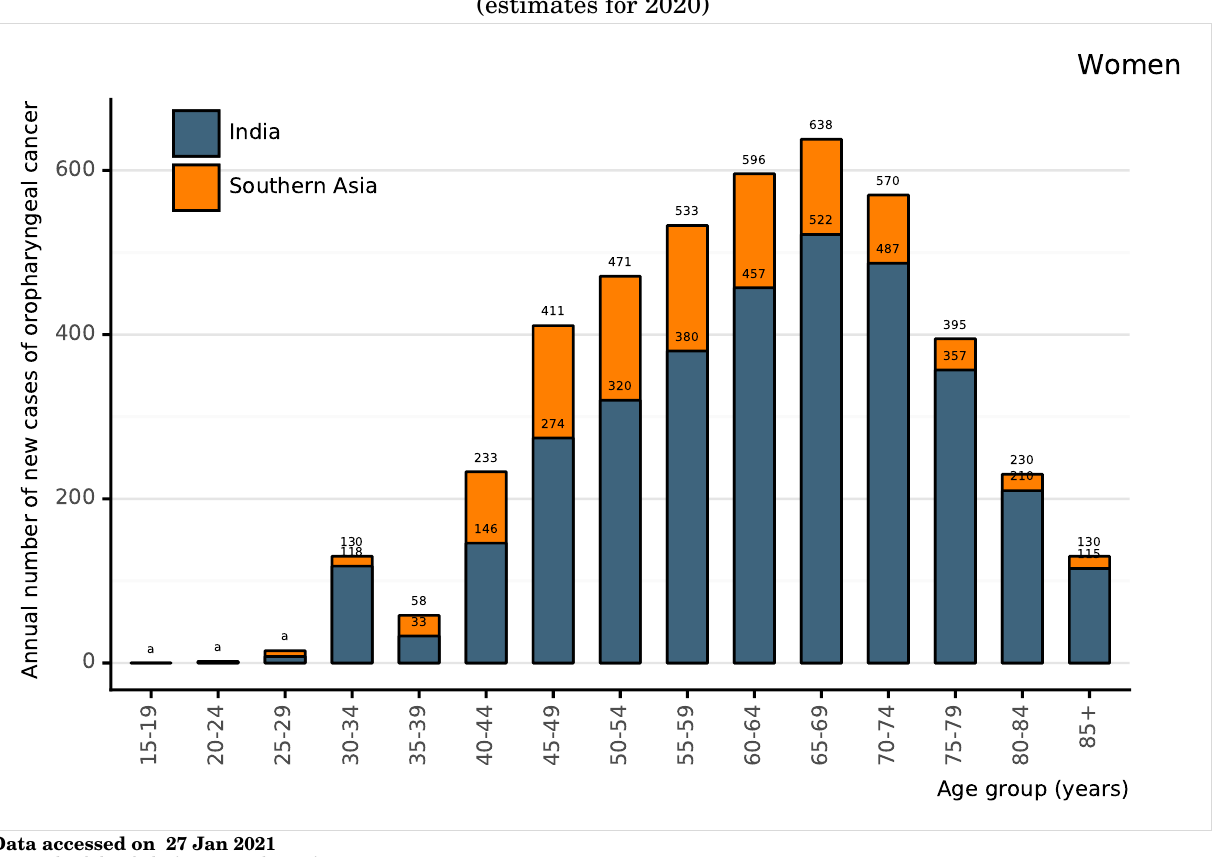
Figure 92: Annual number of new cases of oropharyngeal cancer among women by age group in